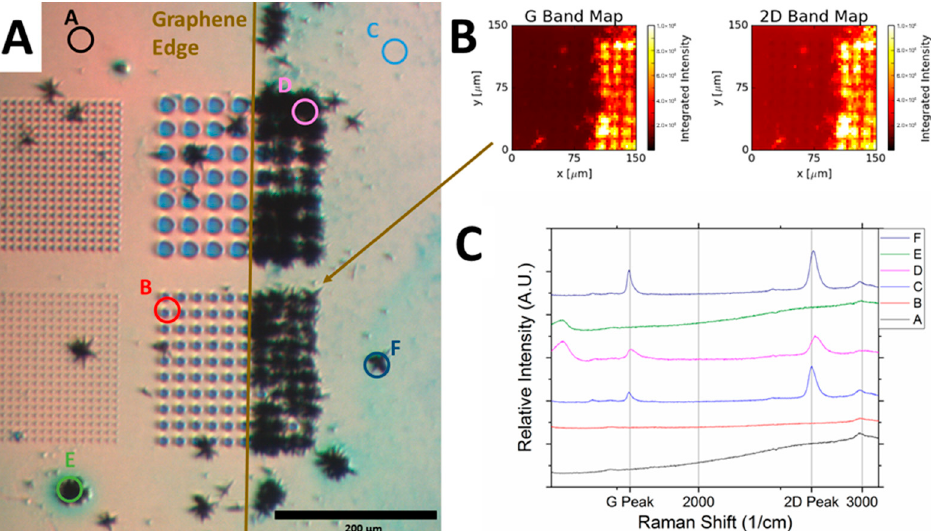
Figure 5. ( a ) Top-view optical microscopy image of a ZnO NWs/graphene sample with partial coverage of graphene. A–F Figure 5. ( A ) Top-view optical microscopy image of a ZnO NWs/graphene sample with partial indicate the locations where Raman measurements were done. ( b ) Raman intensity maps of G and 2D bands confirming coverage of graphene. A–F indicate the locations where Raman measurements were done. ( B ) Raman graphene areas corresponding to the region of ZnO NWs growth. ( c ) Raman spectra collected at the points of A–F. intensity maps of G and 2D bands confirming graphene areas corresponding to the region of ZnO NWs growth. ( C ) Raman spectra collected at the points of A–F.